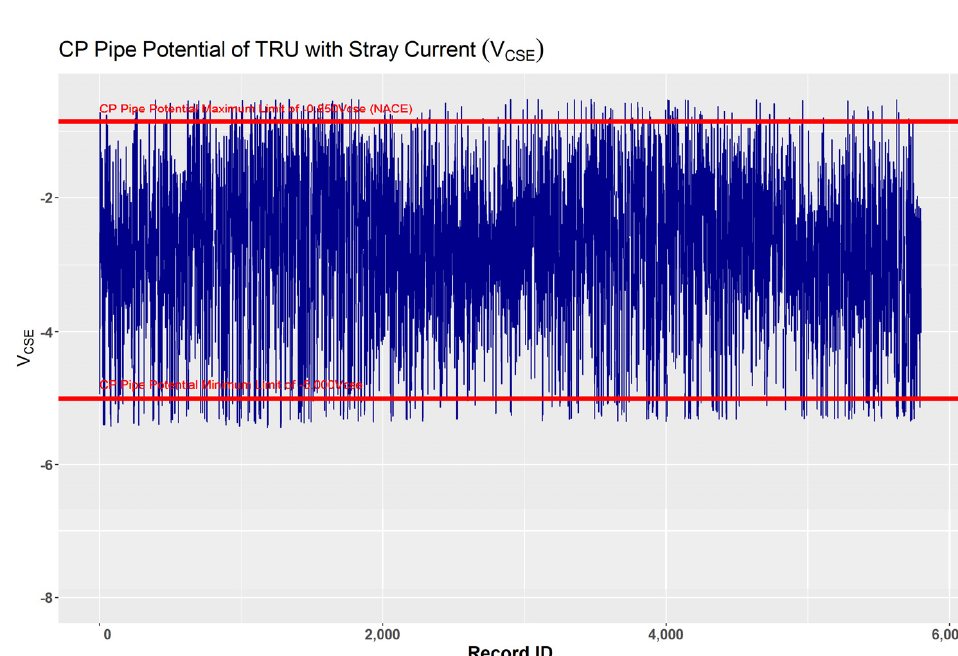
Figure 8. CP Pipe Potential with Stray Current.